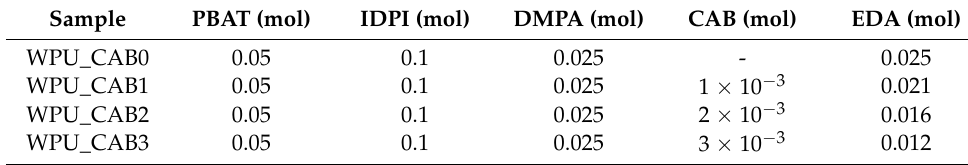
Table 1. WPU dispersions with different contents of chain extender.